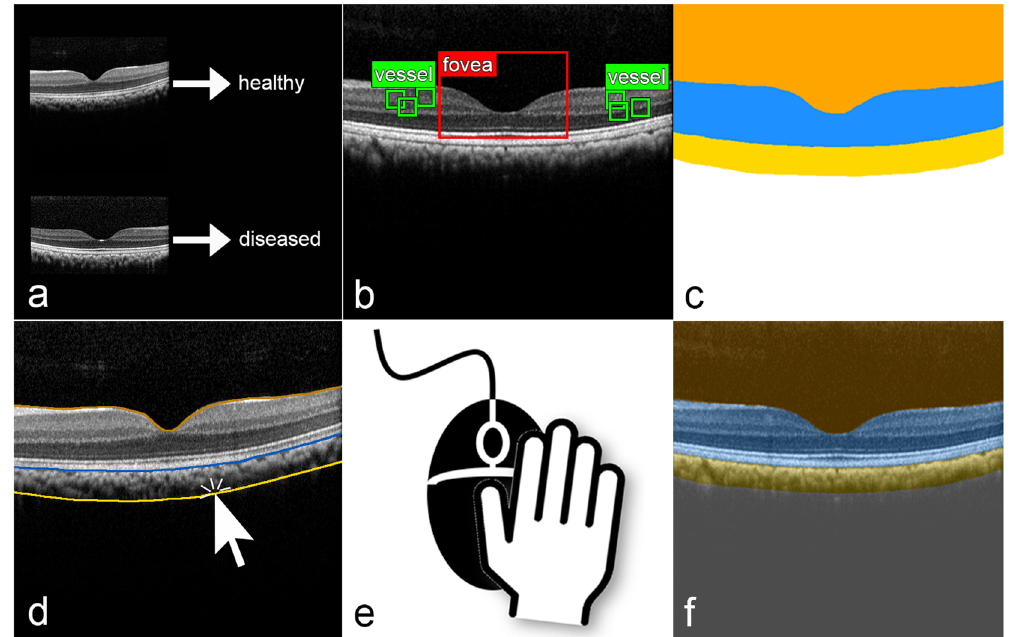
Fig. 7 Display of difference between classi fi cation, object detection, and semantic image segmentation. a Image classi fi cation is the task of assigning each image to one class of a set of classes (e.g. healthy or diseased). b Object detection is the task of identifying and localizing objects in an image (e.g. the fovea identi fi ed and located by the red rectangle or the vessels by the green rectangles). c Semantic image segmentation is the task of assigning each pixel of an image to one class of a set of classes. In this study each pixel of an OCT B-scan was classi fi ed as one of the four major compartments vitreous (orange), retina (blue), choroid (yellow), or sclera (white). d Ground truth was generated by presenting original cross-sectional B-scans to human graders in an online annotation tool. e Human graders drew lines between the four major compartments using a mouse-driven cursor. Pixels that lie between two lines were labeled as the compartment located between the two lines. f Overlay of human-generated labels with B-scan. The fi gure was created with Adobe Photoshop (Version 2021, licence C5004899101EDCH, Adobe, San Jose, US, and Microsoft Powerpoint 365, licence 1446383959, Microsoft, Redmond, US).